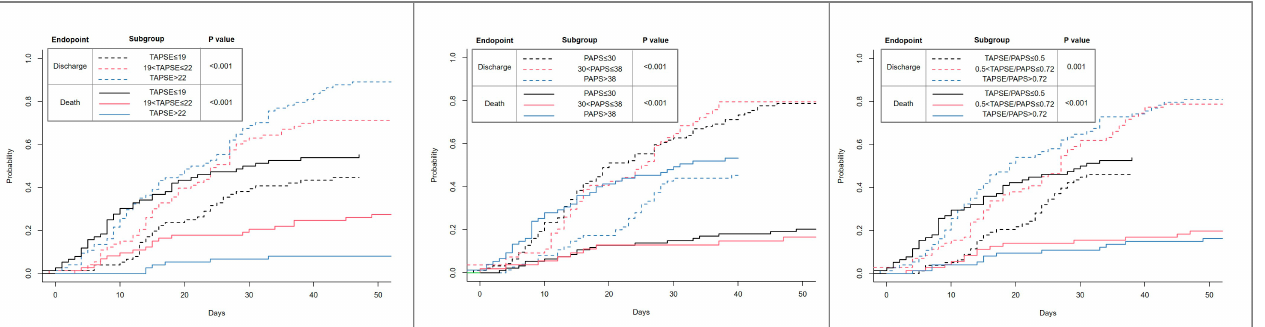
Figure 1. Kaplan–Meier survival curves for discharge free from death and in-hospital mortality, according to TAPSE, PASP, and TAPSE/PASP tertiles.